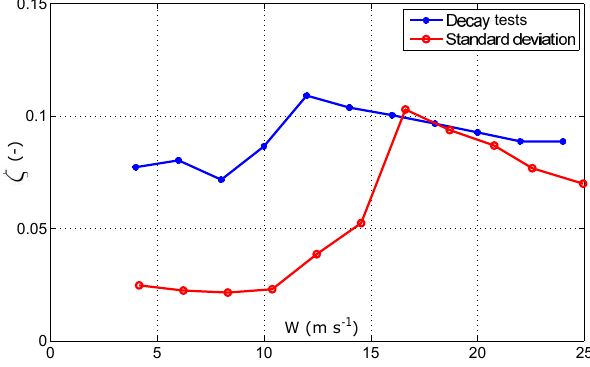
Figure 9. The damping ratio as a function of wind speed for the two methods to calculate the